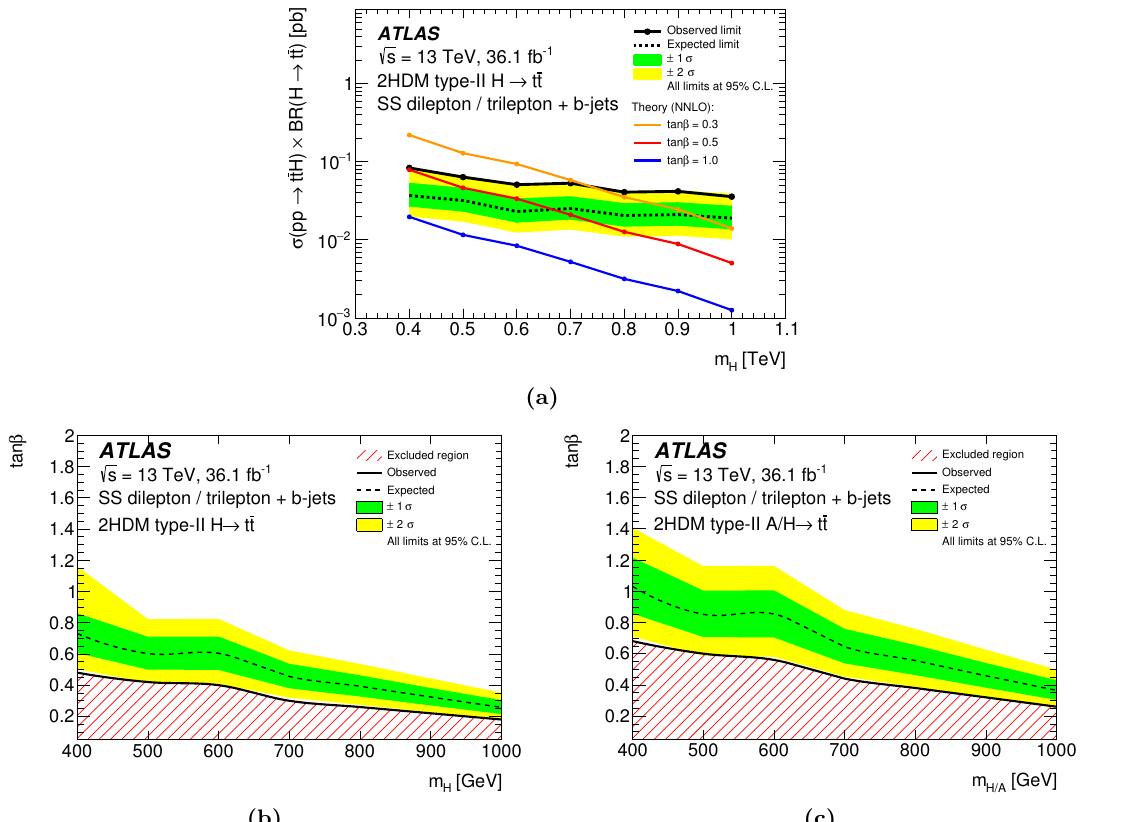
Figure 12 . Limits on the two-Higgs-doublet model interpretation. (a) Limits on the cross-section of the four-top-quark production through a heavy scalar Higgs boson times the branching ratio for the Higgs boson to decay into t (cid:22) t . Theoretical predictions for three values of tan (cid:12) are shown. (b) Limits on four-top-quark production through a heavy scalar Higgs boson in the plane ( m H , tan (cid:12) ). (c) Limits on four-top-quark production considering both a heavy pseudo-scalar and a scalar Higgs boson having the same mass m in the plane ( m , tan (cid:12) ). In all plots, the expected 95% CL H=A H=A limits are shown with their 1 and 2 standard deviation bands. In the context of the two-Higgs- (cid:6) (cid:6) doublet model, the Higgs boson width can be large for low tan (cid:12) . In spite of that, it was checked that the signal e(cid:14)ciency has a negligible dependence on tan (cid:12) in the region of interest. 1 TeV. Considering a full dark-matter model with a dark-sector coupling g = 1, the DM observed (expected) excluded values for the coupling to SM particles are g > 0 : 31 (0 : 28) SM for a mediator mass of m = 3 TeV, and g > 0 : 14 (0 : 13) for m = 1 V SM V